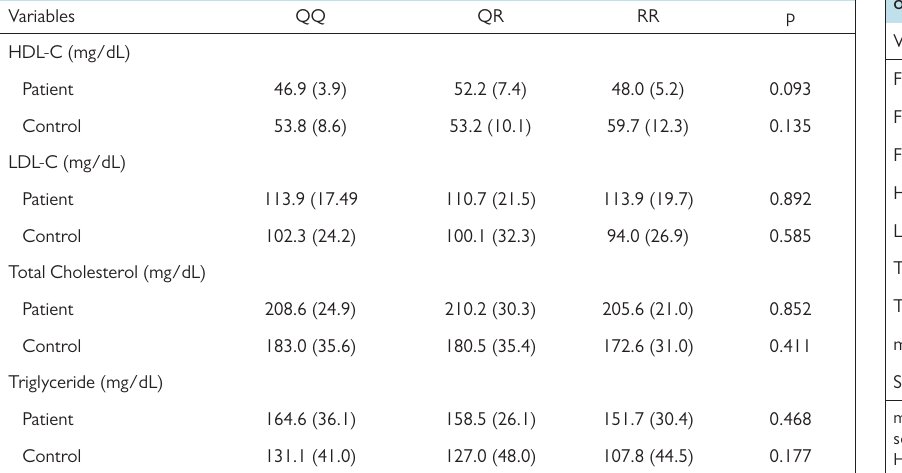
Table 3. Association between lipid profile and PON1 phenotype of the subjects Variables